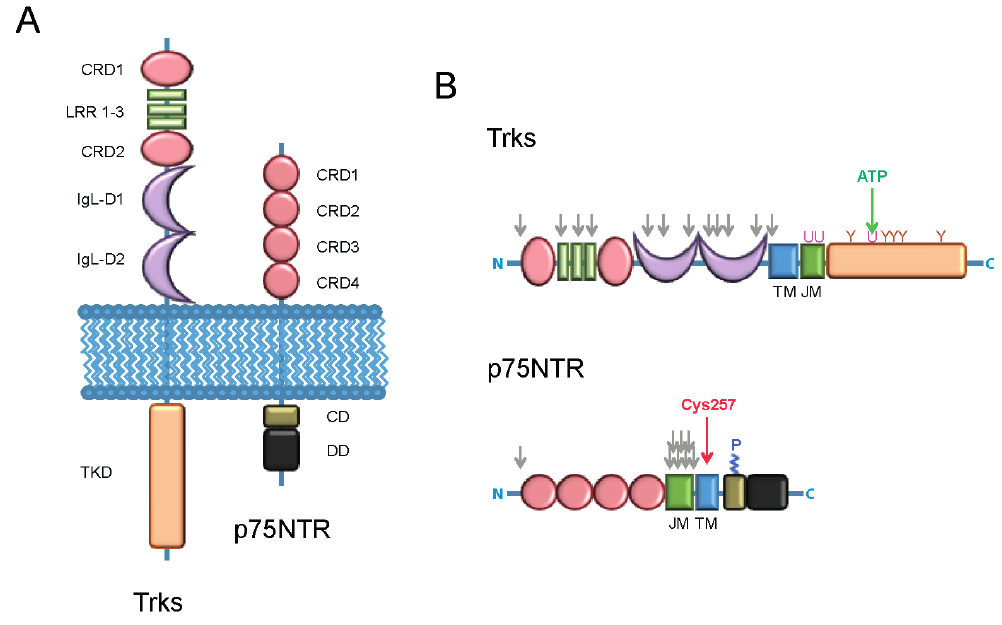
Figure 1. Schematic picture of tropomyosin receptor kinases (Trks) and the p75 neurotrophin receptors (p75NTR). ( A ) Structure of the two receptors: The intracellular (on top ) and extracellular (on bottom ) domains are highlighted. The following abbreviations are used: CRD (cystein-rich domain); LRR (leucine-rich domain); IgL-D (immunoglobulin-like domain); TKD (tyrosine-kinase domain); CD (chopper domain); DD (death domain); ( B ) Modified residues of the Trks (on top ) and of p75NTR (on bottom )